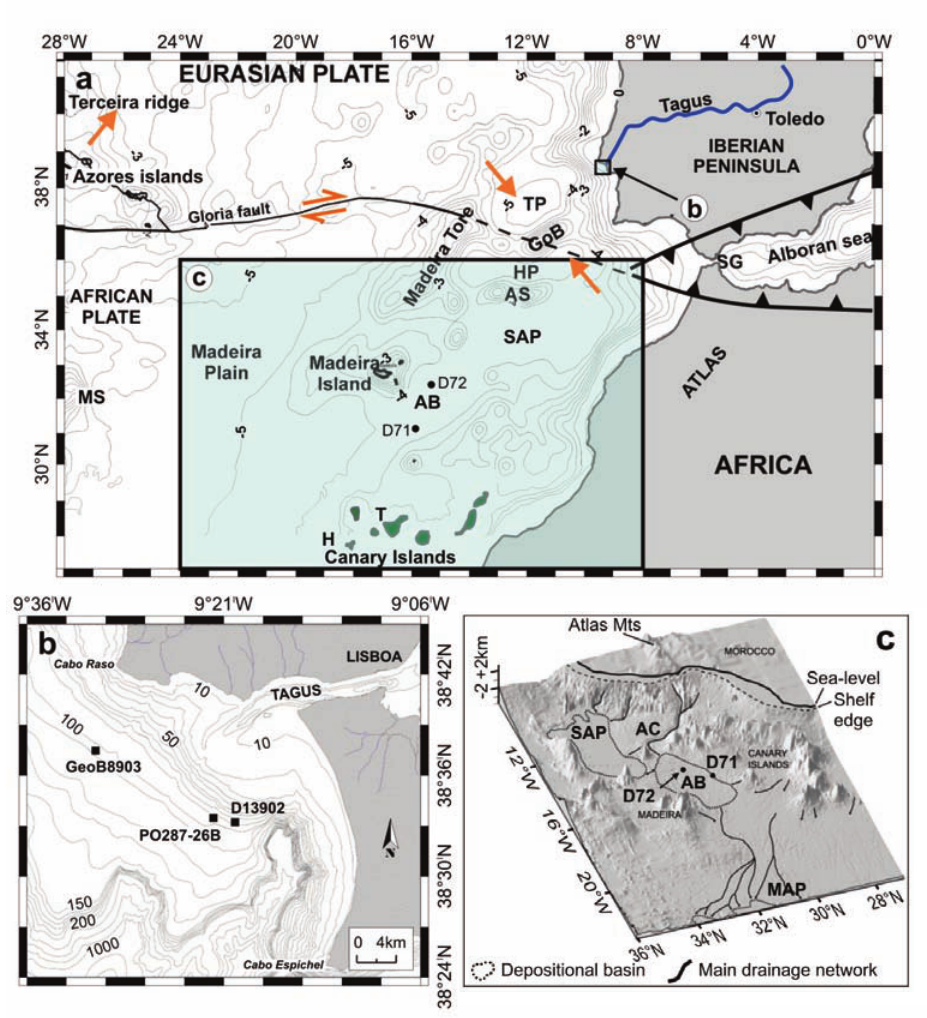
Figure 3. (a) Tectonic sketch and bathymetric map of the North-East Atlantic, with 500 m contour intervals. Orange arrows, plate convergence motion; orange semi-arrows, transform motion [after Morel and Meghraoui 1996, Jiménez-Munt et al. 2001]. Abbreviations: GB, Galicia Bank; TP, Tagus Plain; GoB, Gorrige Bank; HP, Horseshoe Plain; AS, Ampere Seamount; SAP, Seine Abyssal Plain; AB, Agadir Basin; SG, Strait of Gibraltar; H, El Hierro Island (Canaries); T, Tenerife Island (Canaries); MS, Meteor Seamounts. Rectangles b and c show the frames of panels (b) and (c) respectively. (b) Area offshore of the Tagur River estuary (West Iberian Margin); 10 m and 200 m contour intervals. Cores GeoB8903, D13902 and PO287-26B are mentioned in the main text [modified from Abrantes et al. 2005]. (c) Three-dimensional image of the NW African margin, showing the locations of the Canary Islands, the Agadir Basin (AG), the Madeira Abyssal Plain (MAP), and the Seine Abyssal Plain (SAP). Perspective view of panel (c) from Wynn and Masson (2003). Cores D71 and D72 of panels (a) and (c) are mentioned in the main text (modified from Wynn and Masson,